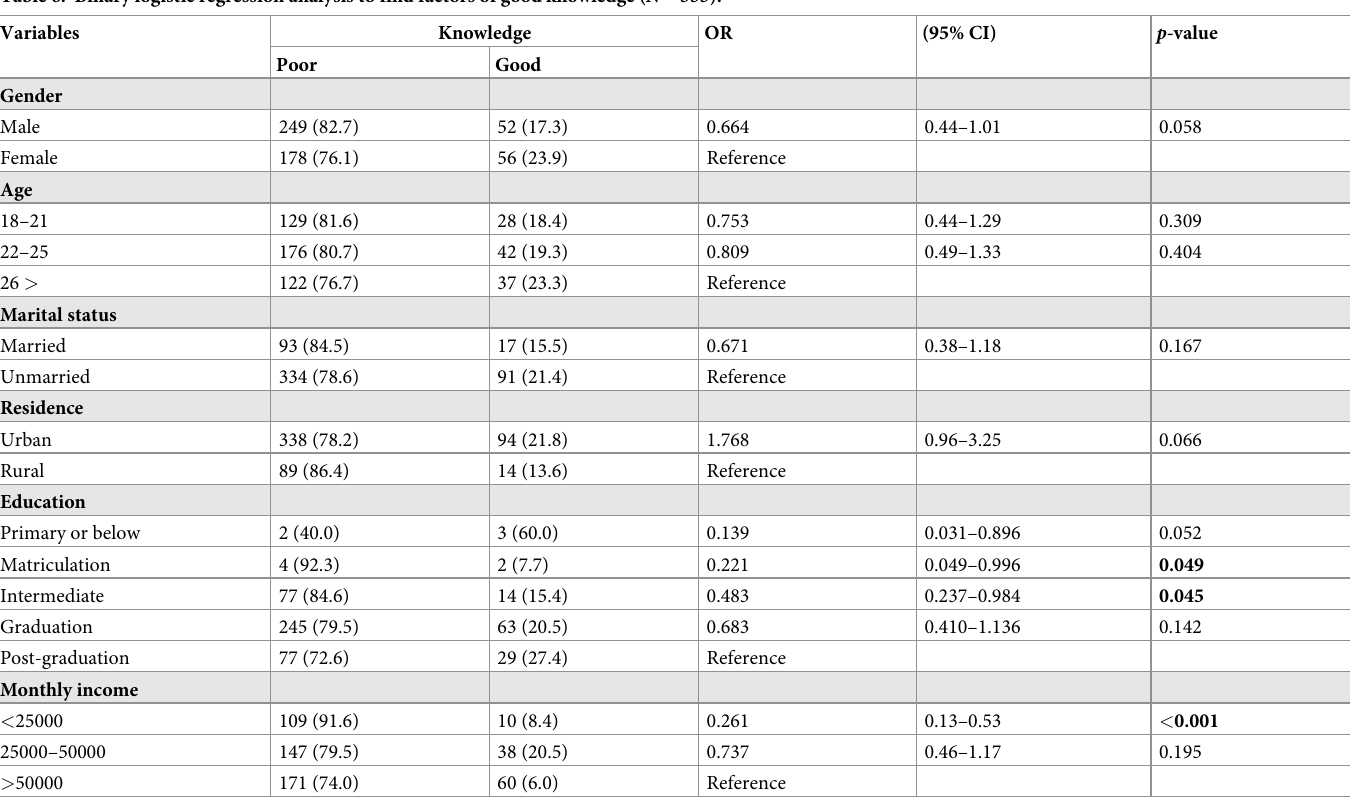
Table 6. Binary logistic regression analysis to find factors of good knowledge ( N =